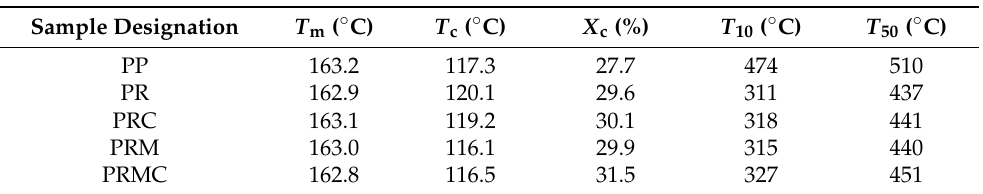
Table 8. Thermal properties of neat PP and its composites.